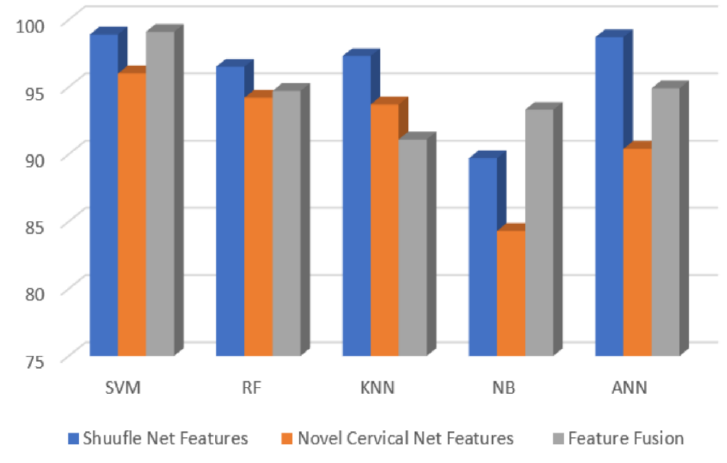
Figure 9. Comparison between various scenarios.